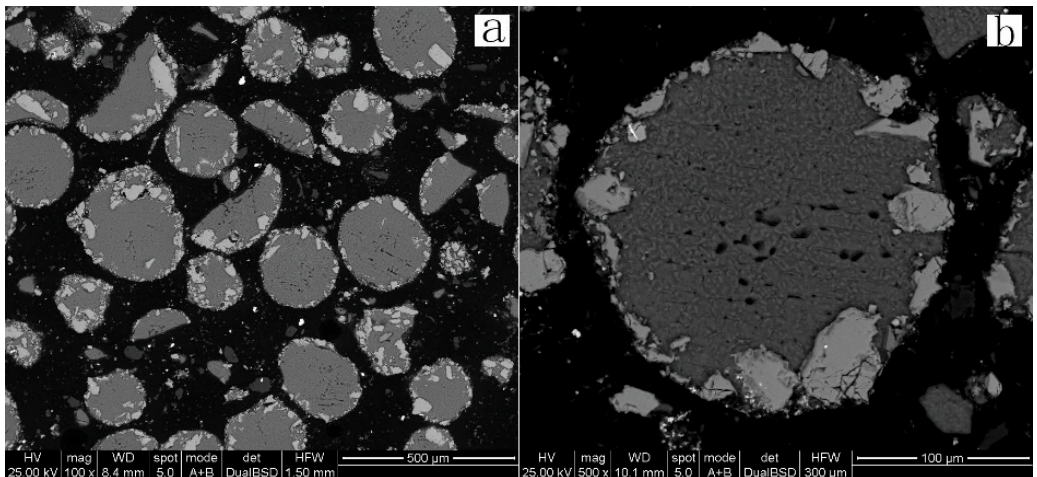
Figure 17. BSE images of 150 °C leach residues. Scale: ( a ) 500 μ m; ( b ) 100 μ m.